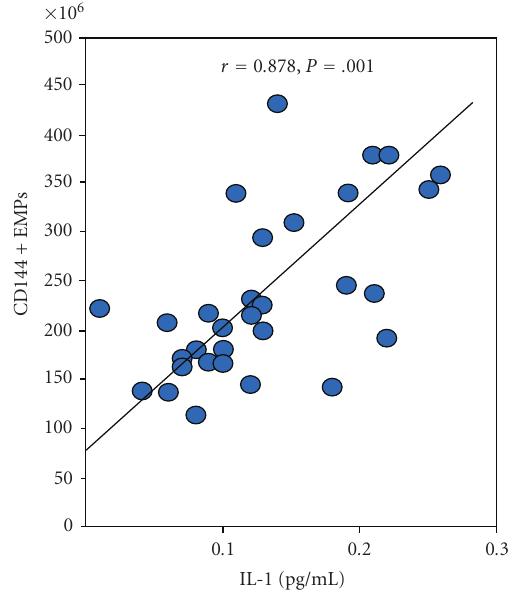
Figure 4: Correlation plot and linear regression line between CD144+ EMPs and the cytokine